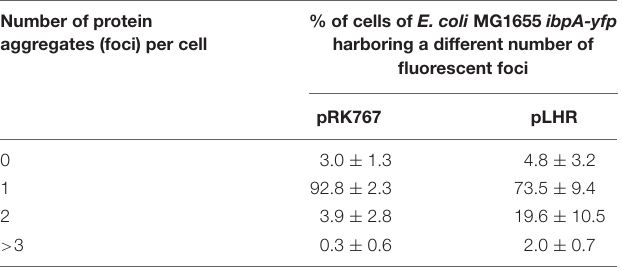
TABLE 3 | Differential enumeration of cells containing none, one, two, or more than three foci representing protein aggregates in E. coli MG1655 ibpA-yfp (pRK767) and E. coli MG1655 ibpA-yfp (pLHR). Number of protein aggregates (foci) per cell